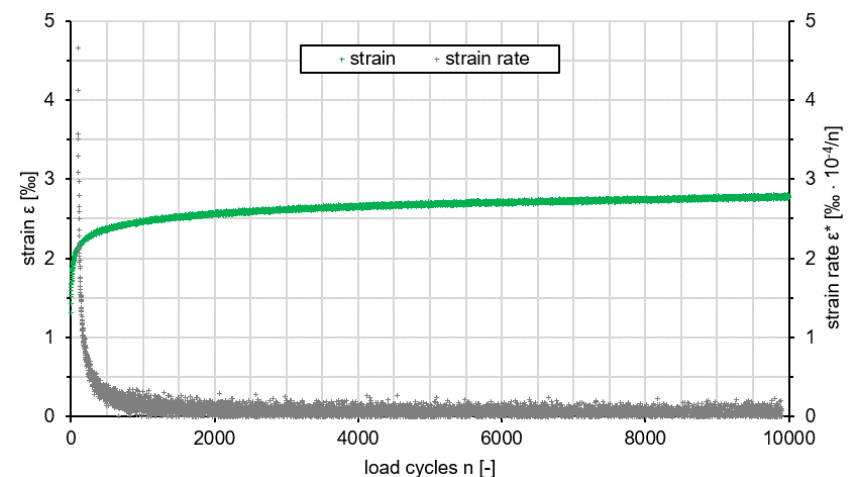
Figure 10. Results of the pressure swelling test and impulse creep curve (green) and strain rate (grey) of Var